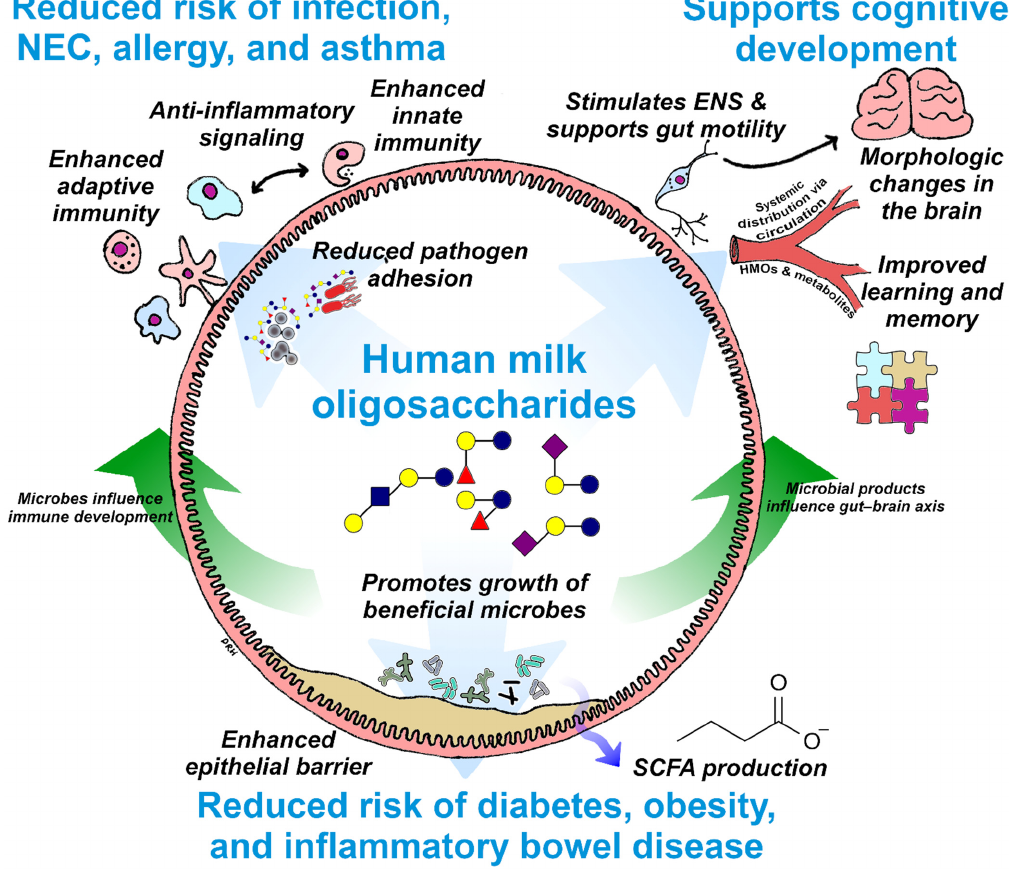
Figure 3. Summary of the known beneficial effects of HMOs in supporting digestive health, immunity, and cognition and an illustration of the interconnections between these benefits. Potential impacts on infant health, such as reduced risk of chronic disease and enhanced cognitive development, are highlighted in blue text. ENS, enteric nervous system; SCFA, short chain fatty acid; NEC, necrotizing enterocolitis; HMO, human milk oligosaccharides.